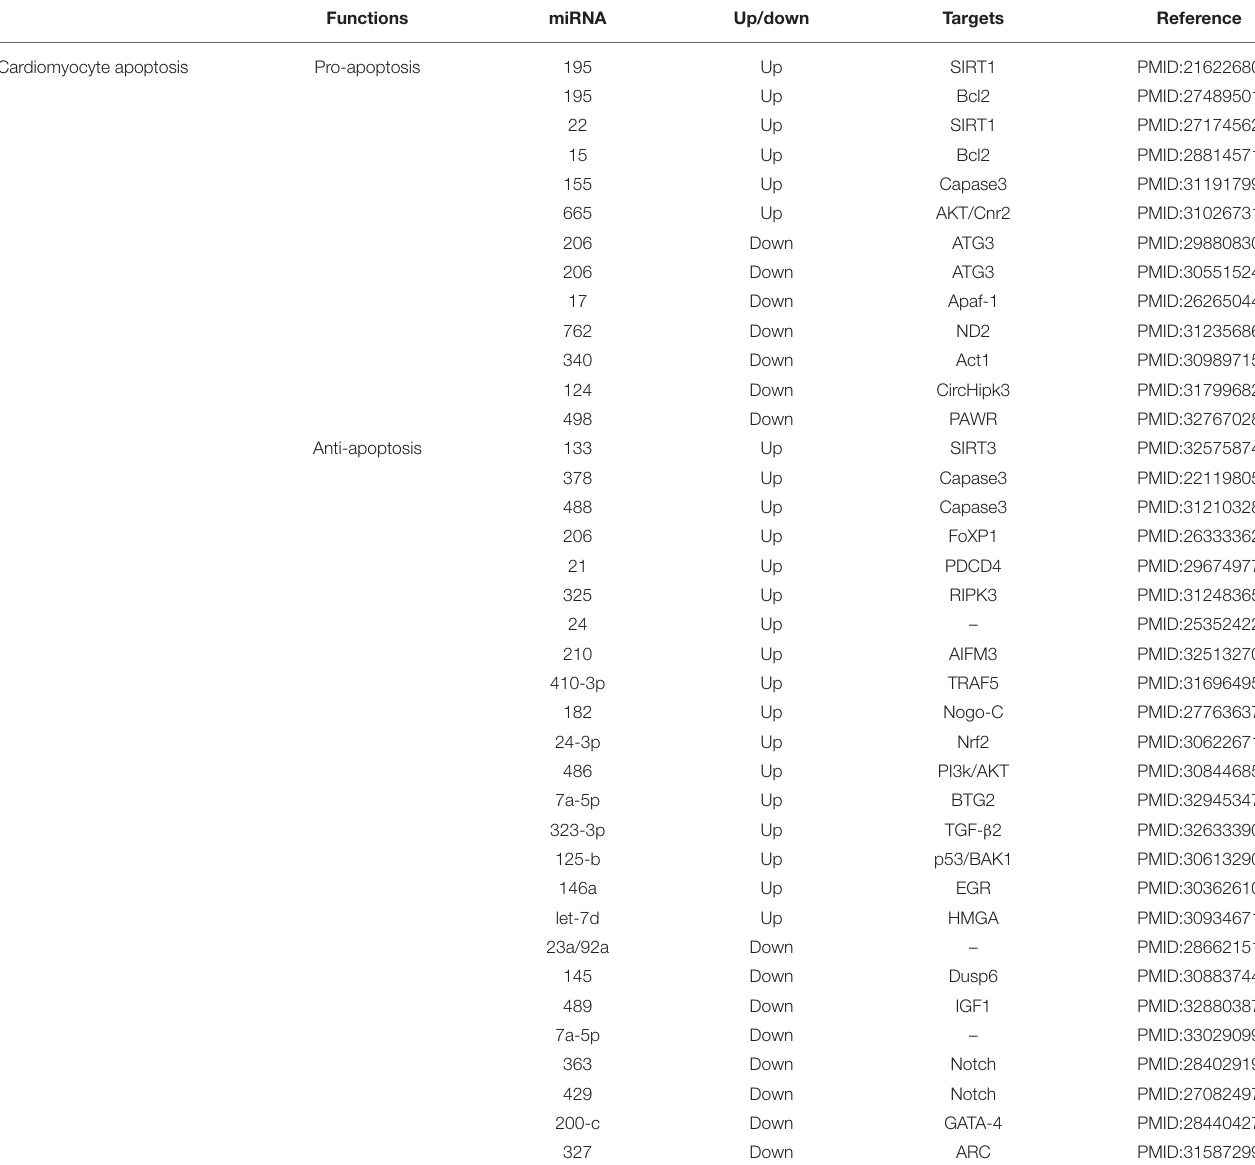
TABLE 1 | Micro RNAs targets and functions in cardiomyocyte